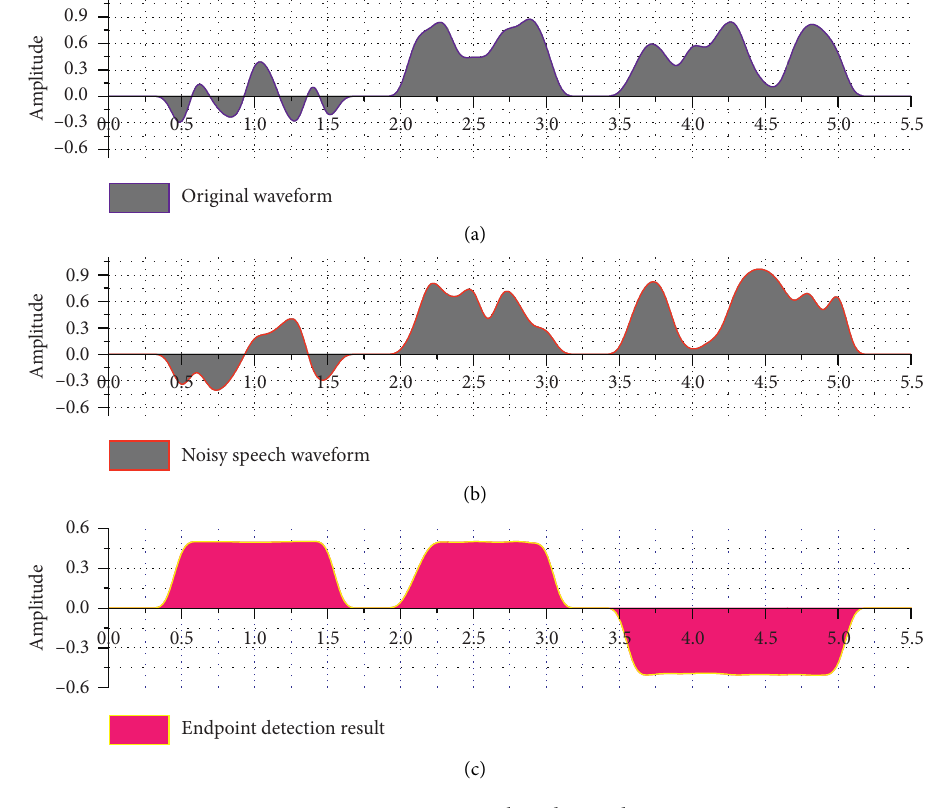
Figure 1: Continuous speech endpoint detection. Table 1: Class connection